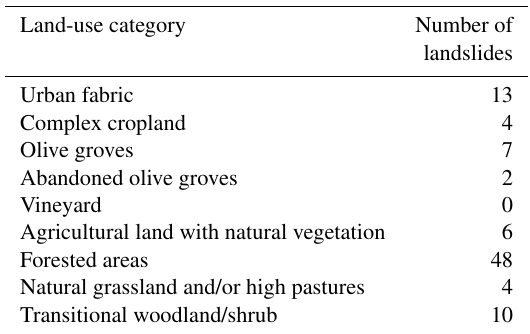
landslides 0 6 48 4 10